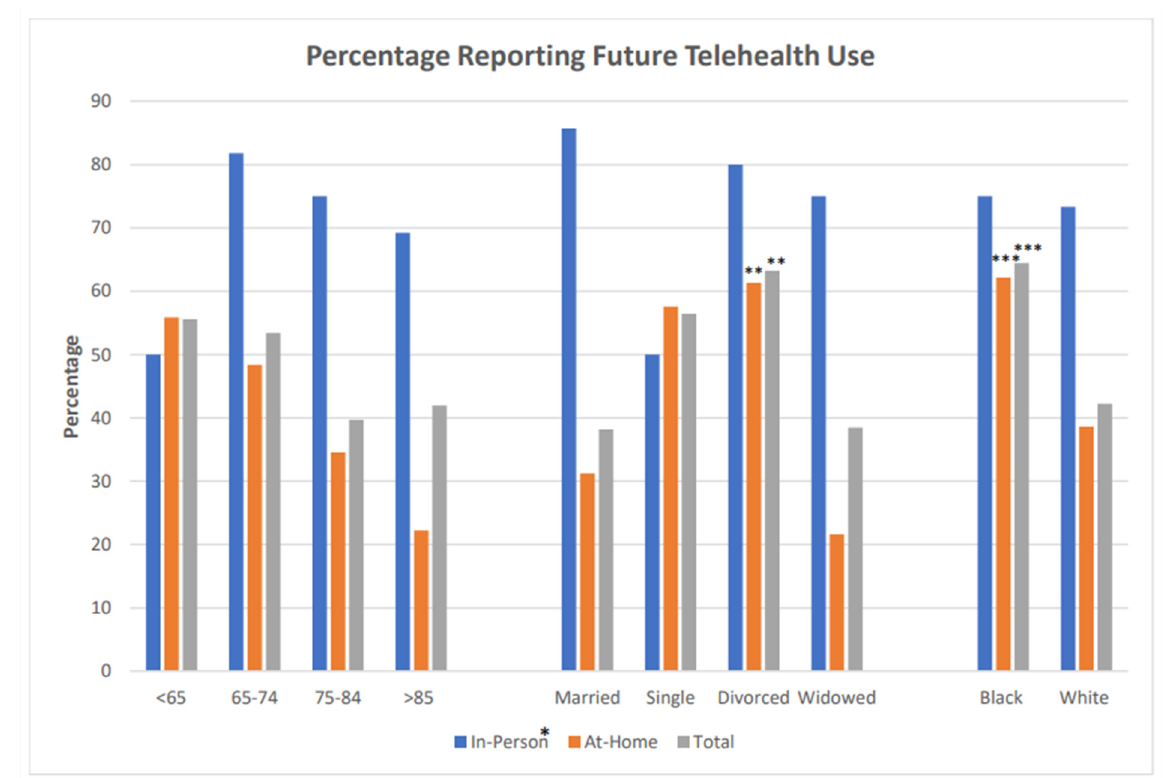
Figure 1. Differences in Stated Likelihood of Future Use. * In-Person learners reported increased likelihood of future use compared to at-home learners. ** Divorced participants were more likely than married or widowed participants to use telehealth among at-home learners and for the entire population. *** Black participants reported increased likelihood of future use compared to white participants.